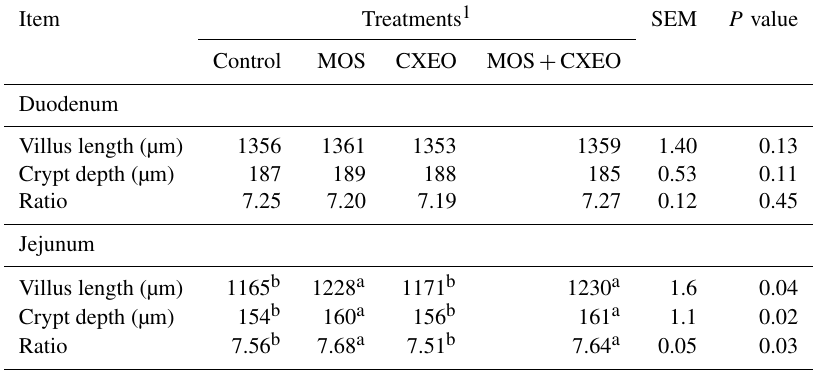
Table 5. Effect of mannan oligosaccharide (MOS) and Curcuma xanthorrhiza essential oil (CXEO) on intestinal morphometry in broilers subjected to heat challenge.